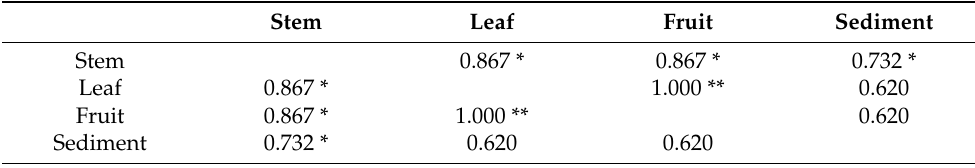
Table 5. Summary of Kendall’s correlation coefficient (stem, leaves, fruits, sediment). Stem Leaf Fruit